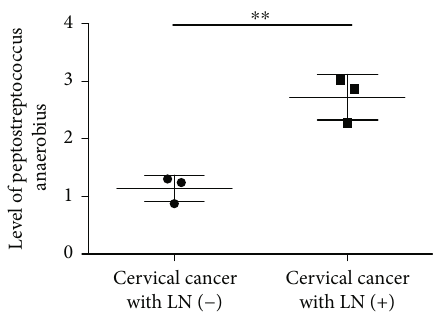
Figure 1: The level of Peptostreptococcus anaerobius in cervical